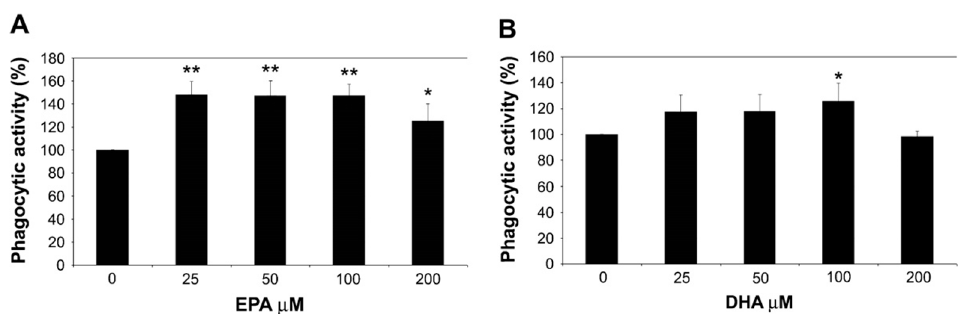
Figure 1. E ff ects of eicosapentaenoic acid (EPA ( A ) and docosahexaenoic acid (DHA) ( B ) on the phagocytic activity of caprine monocytes ( p < 0.05, ** p < 0.01; [110], modified).